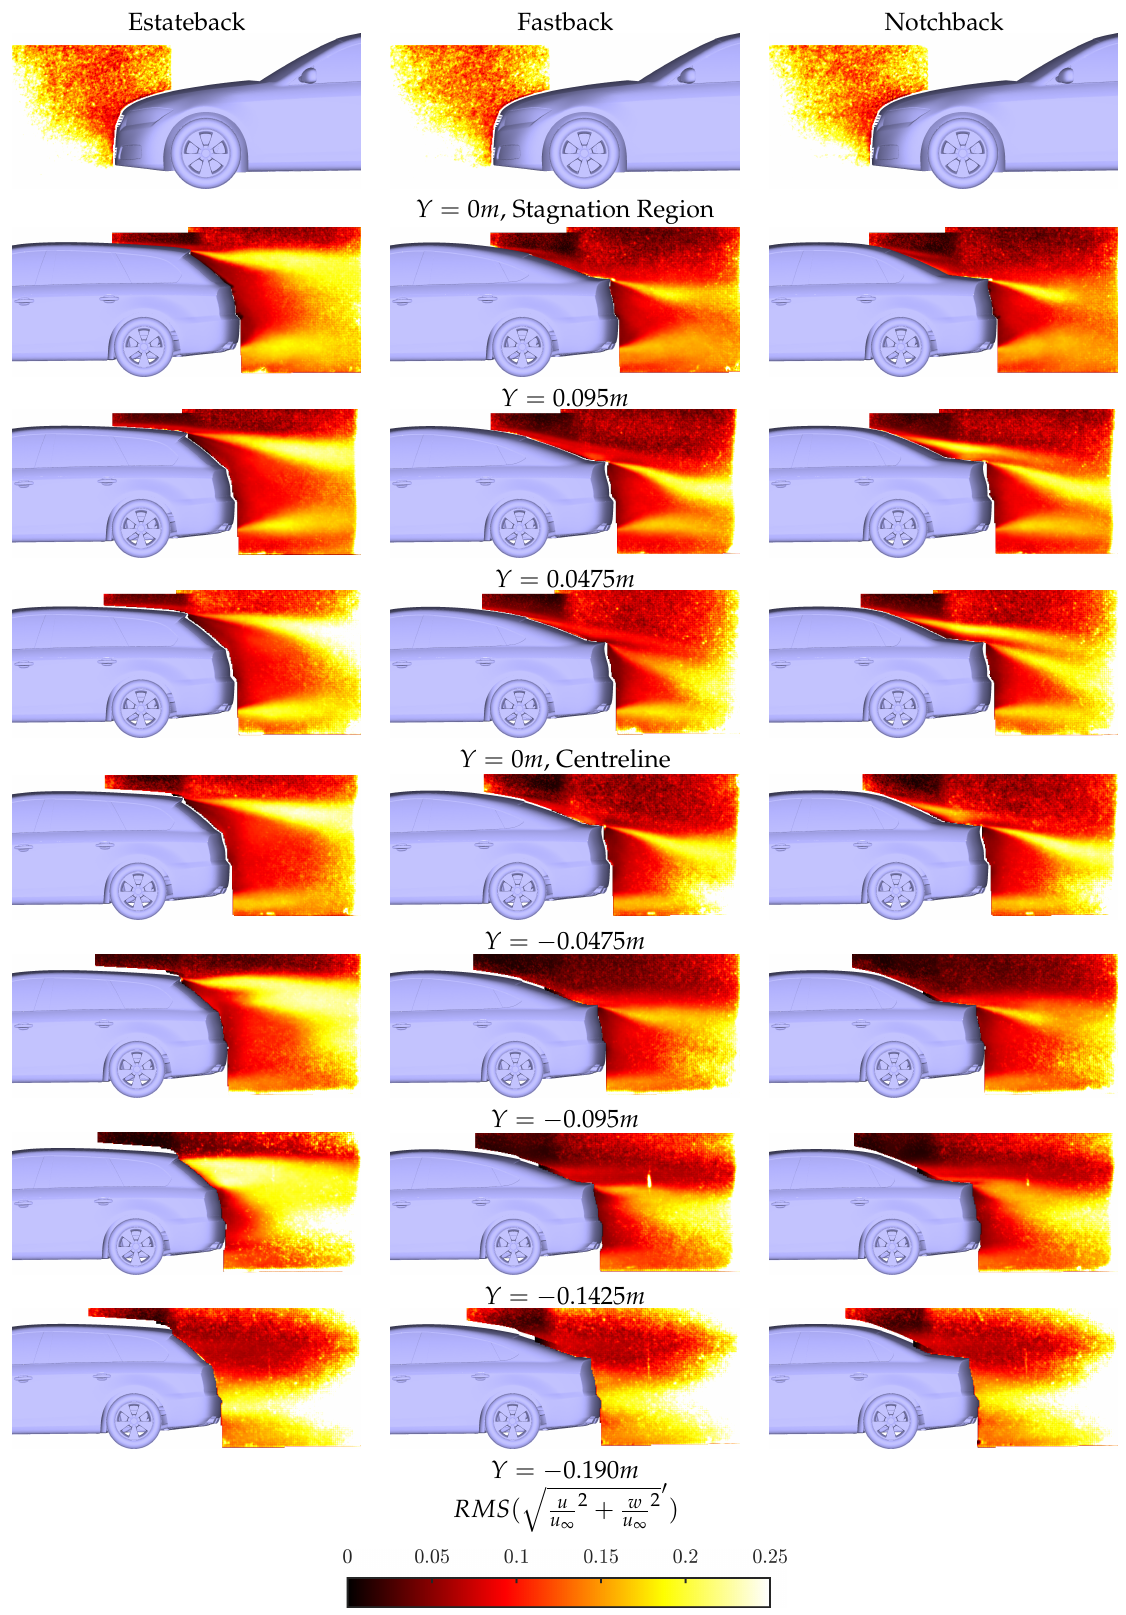
Figure 15. Side profile for all PIV planes of root mean squared of the normalised velocity magnitude fluctuations for all three DrivAer configurations